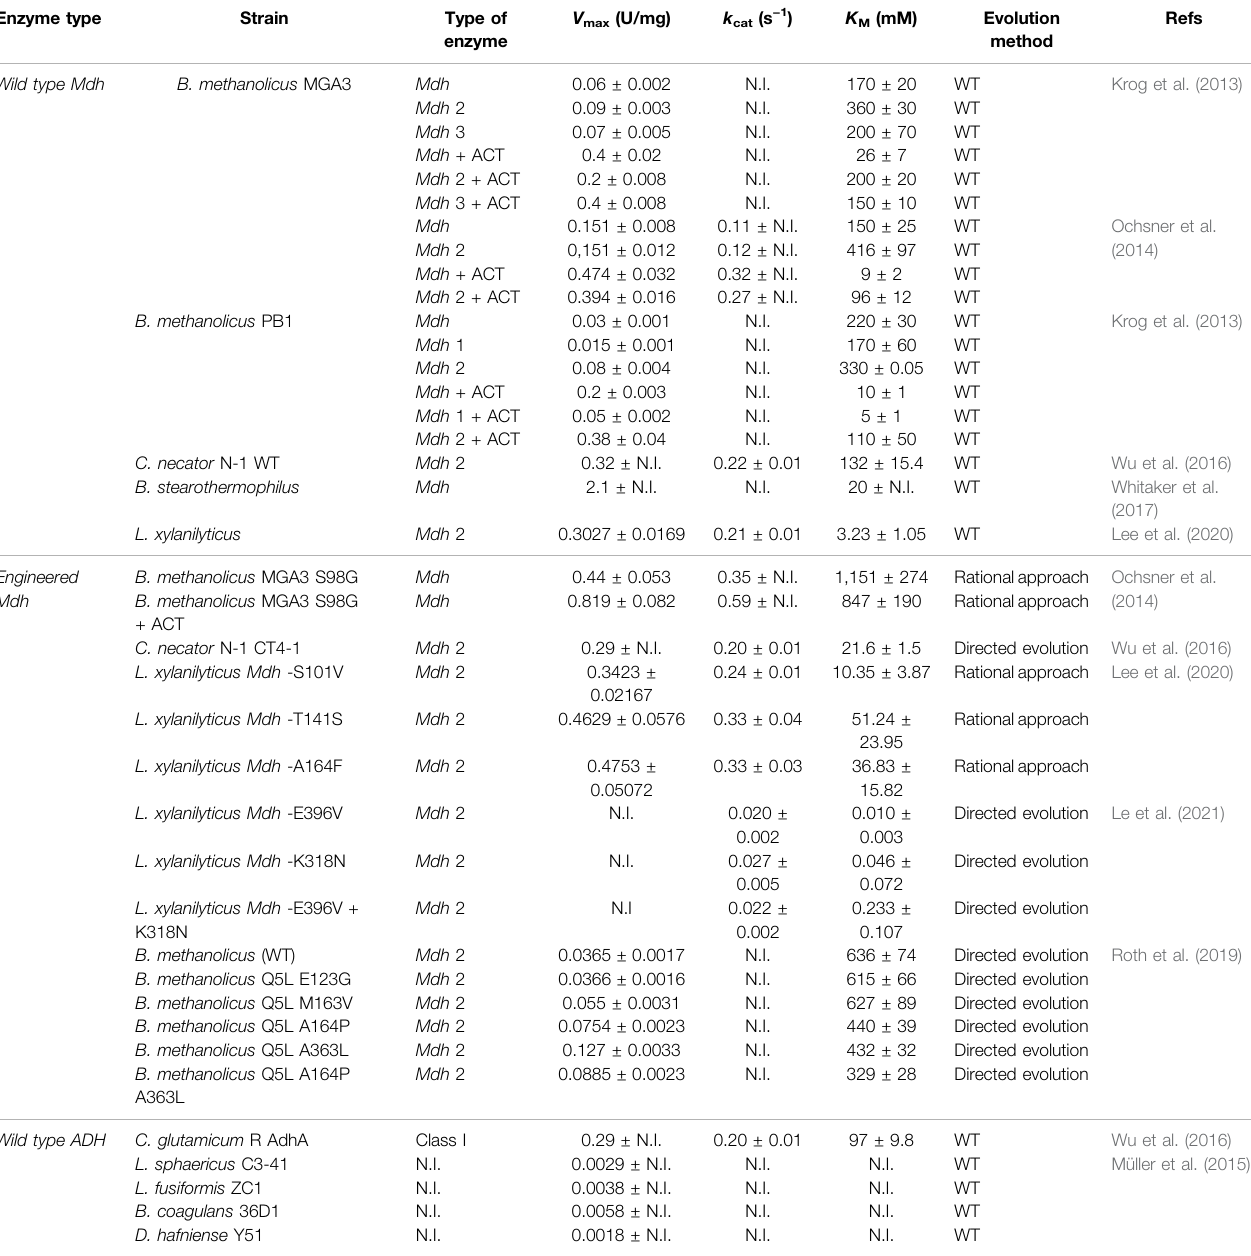
TABLE 2 | Summary of substrate af fi nity for methanol by NAD + -Dependent Mdhs. Enzyme type